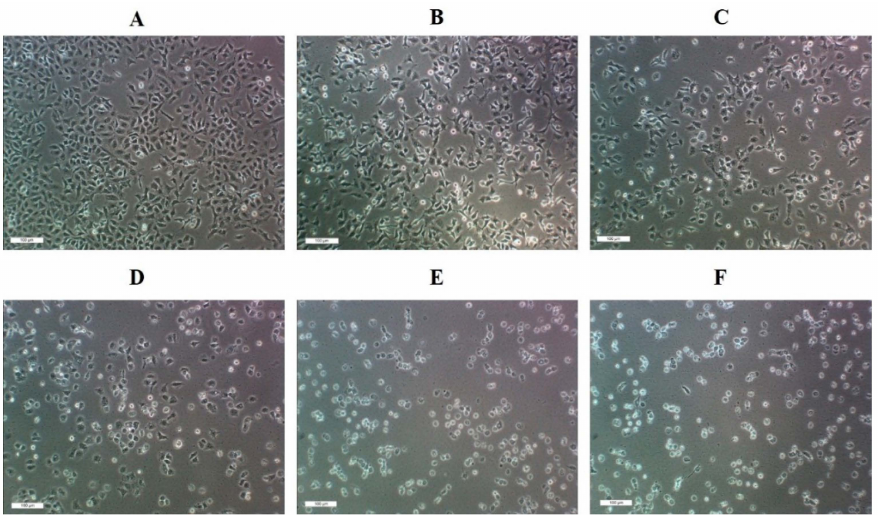
Figure 5. Morphology of A549 cells after a 24-h treatment with DMSO ( A ); 25, 50, and 75 µ g/mL SNL ( B , C , and D , respectively), and HA/SNL aggregates 25 ( E ) and 50 ( F ).